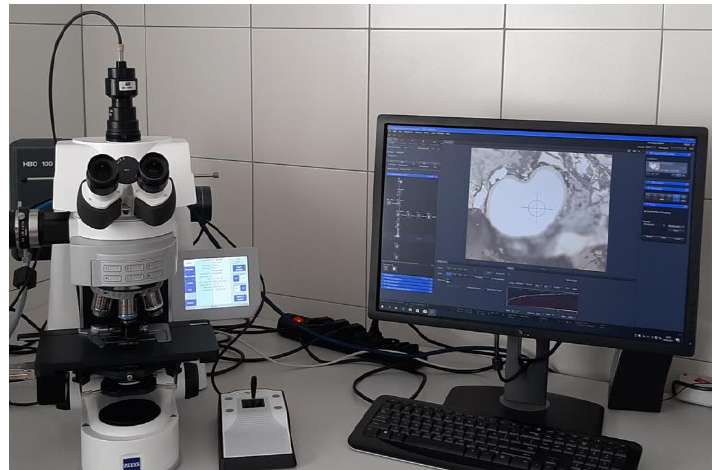
Figure 3. Microscope Zeiss Axio Imager Z 2m.